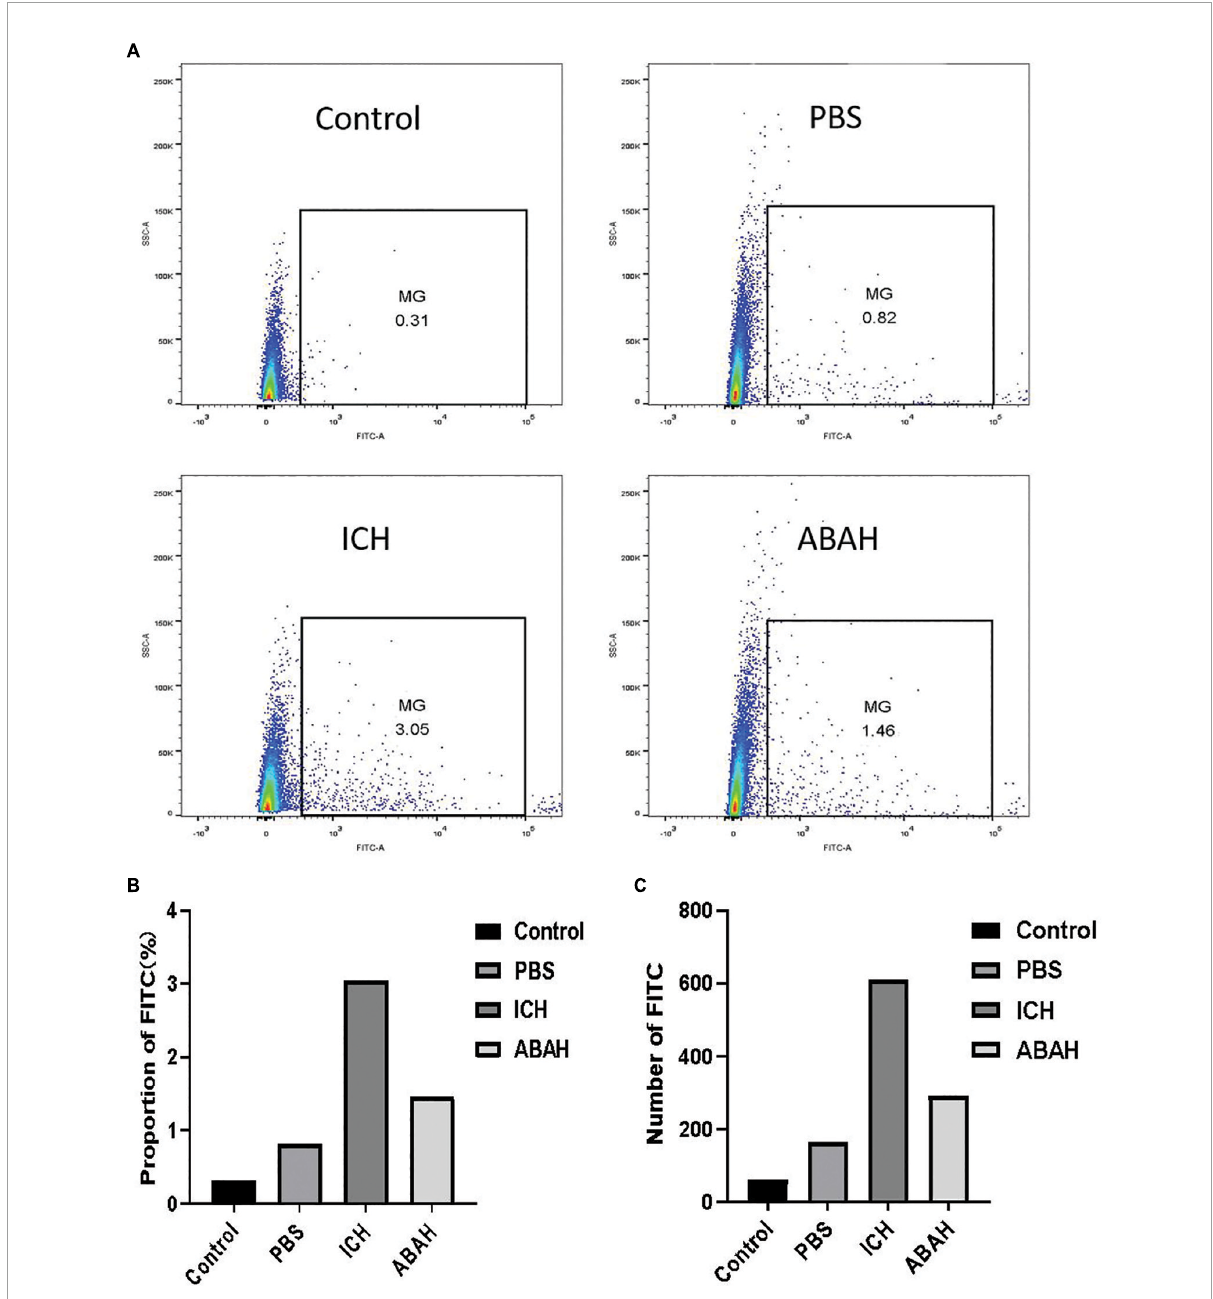
FIGURE3 Inhibition of MPO activity reduces microglia proliferation following ICH. (A) Flow cytometry FITC channel, to detect the content of microglia in the control, PBS, ICH, and ABAH groups (set the total number of living cells to 20,000, n = 1 in each group); (B) proportion of FITC in the control, PBS, ICH, and ABAH groups; (C) number of FITC in the control, PBS, ICH, and ABAH